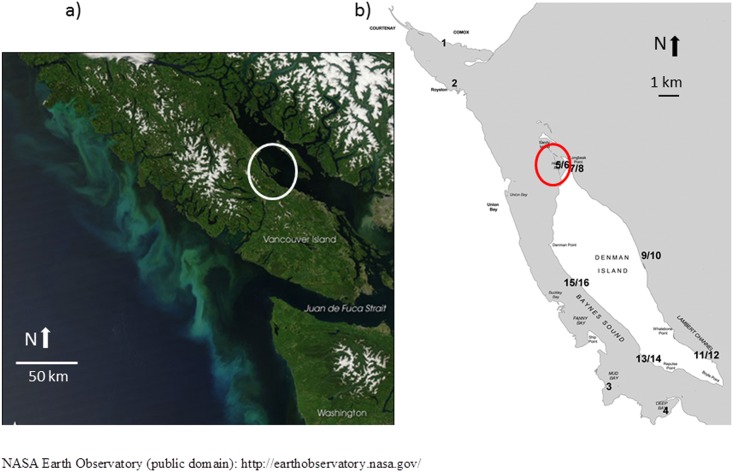
(a and b.) Location of the study site, Baynes Sound and Lambert Channel (Lat: 49° 31’59.99” N Long: -124 ° 49’ 59.99” W) (a), and study site sampling locations (b).Sample sites are as follows: 1 Comox Estuary Low Tide, 2 Royston Bay Low Tide, 3 Mud Bay Low Tide, 4 Deep Bay Low Tide, 5/6 Henry Bay Low and High Tide, 7/8 Morningside Beach Low and High Tide, 9/10 Fillongley Park Low and High Tide, 11/12 Gravelly Bay Low and High Tide, 13/14 Metcalfe Bay Low and High Tide, Ferry Terminal Low and High Tide 15/16. Sites 1–6 and 13–16 are within Baynes Sound, whereas sites 7–12 are within Lambert Channel. The shallow underwater plateau is indicated with a red circle [24].